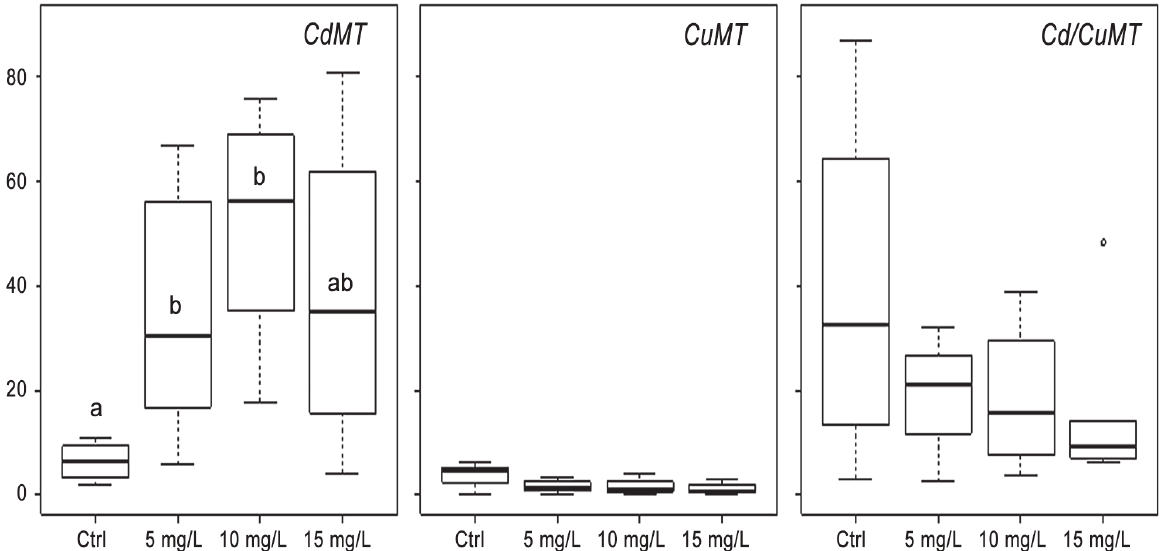
Fig 5. MT isoform mRNA transcription values (thousand mRNA copy numbers/10 ng of total RNA) of the CdMT , Cd/CuMT and CuMT genes in 12- day-old embryos of Cantareus aspersus ( n = 4) exposed to increasing Cd concentrations (C, control; 5 mg/L, 10 mg/L and 15 mg/L). Box plots indicate the median values (bold line) for each group, the edges of the boxes are the 25 th and 75 th percentiles. The whiskers represent the 10 th and 90 th percentiles. The white dot is the extreme values. Significant differences (Mann-Whitney U test, p < 0.05) of transcription levels of the three MT isoform genes are indicated by differing lower case letters (a, b).